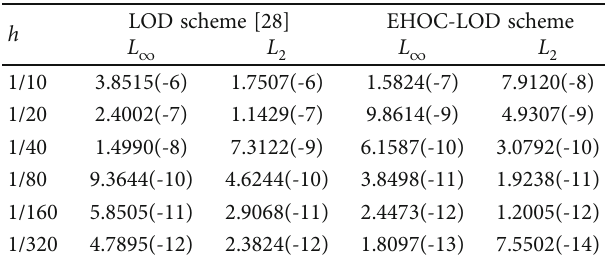
Table 2: L and L ∞ norm errors when T = 0 : 02 and τ = 0 : 0002 for 2 Example 1.